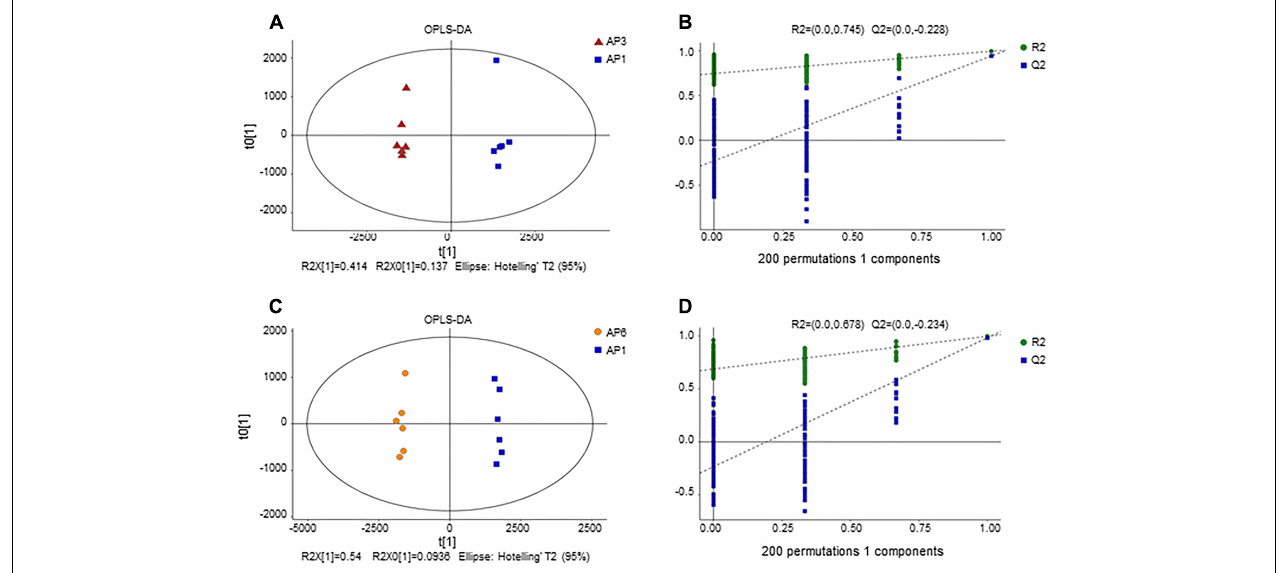
FIGURE 2 | OPLS-DA score plot for samples. (A) OPLS-DA score plots from metabolite profiles for AP3 and AP1 samples. (B) A 200 times permutation test of OPLS-DA models for (A) . (C) OPLS-DA score plots from metabolite profiles for AP6 and AP1 samples. (D) A 200 times permutation test of OPLS-DA models for (C) .